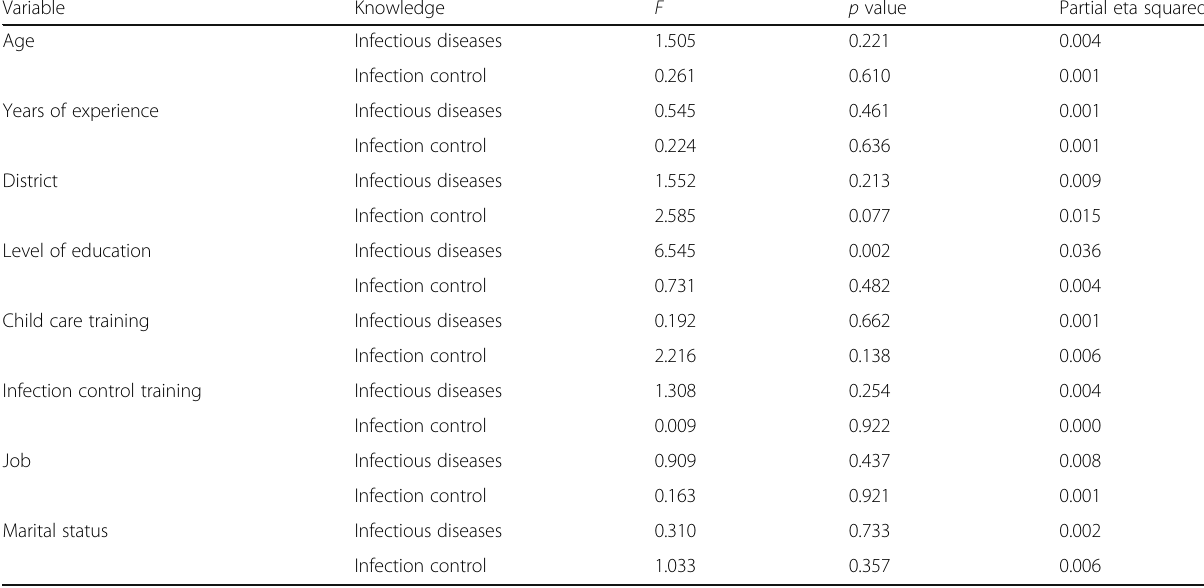
Table 2 MANOVA univariate test of factors affecting infectious disease and infection control knowledge of caregivers (Alexandria, 2015)